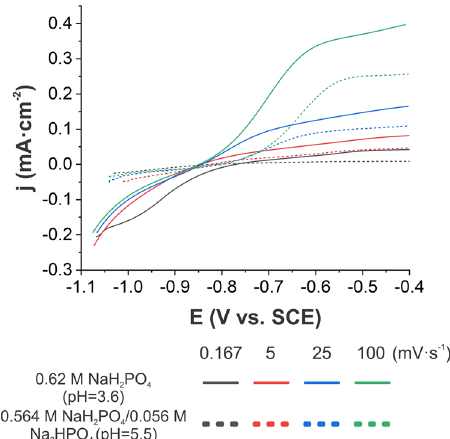
Fig. 7 Effect of pH and buffer on PDP. Current density of PDP measured in 0.62 M NaH 2 PO 4 and 0.564 M Na 2 HPO 4 /0.056 M NaH 2 PO 4